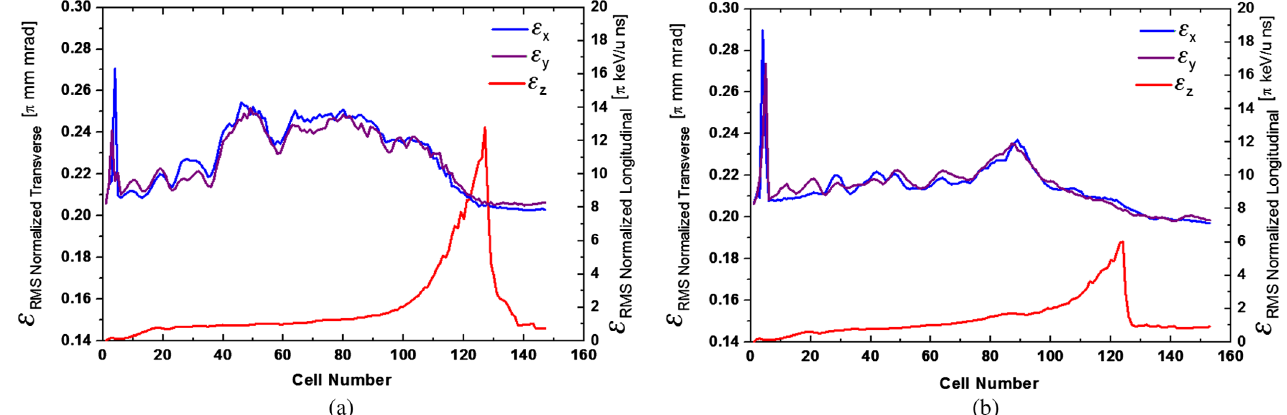
FIG. 3. The normalized RMS emittances of the designs before (a) and after (b) optimization.